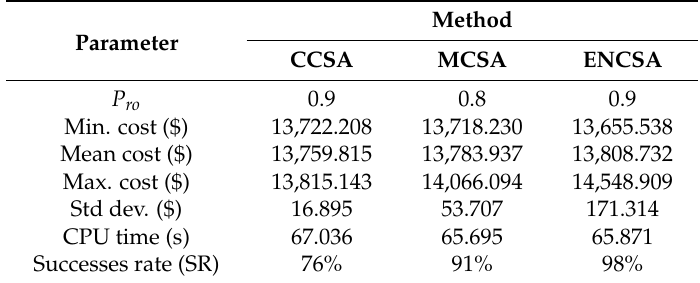
Table 4. Comparison of obtained results for the IEEE 30 buses system.